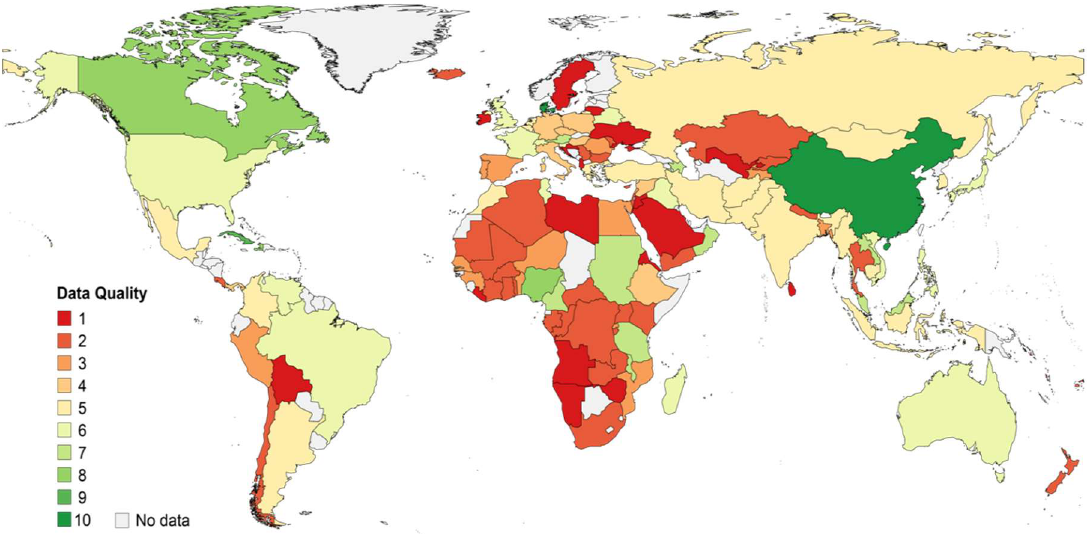
Figure 2. Quality of acquired HBV genotyping data per country. One (red) indicates the lowest and ten (green) represents the highest data quality. The scoring system was based on the sampling region, study population, sampling year, genotyping method, year of analysis, and number of analyzed samples.